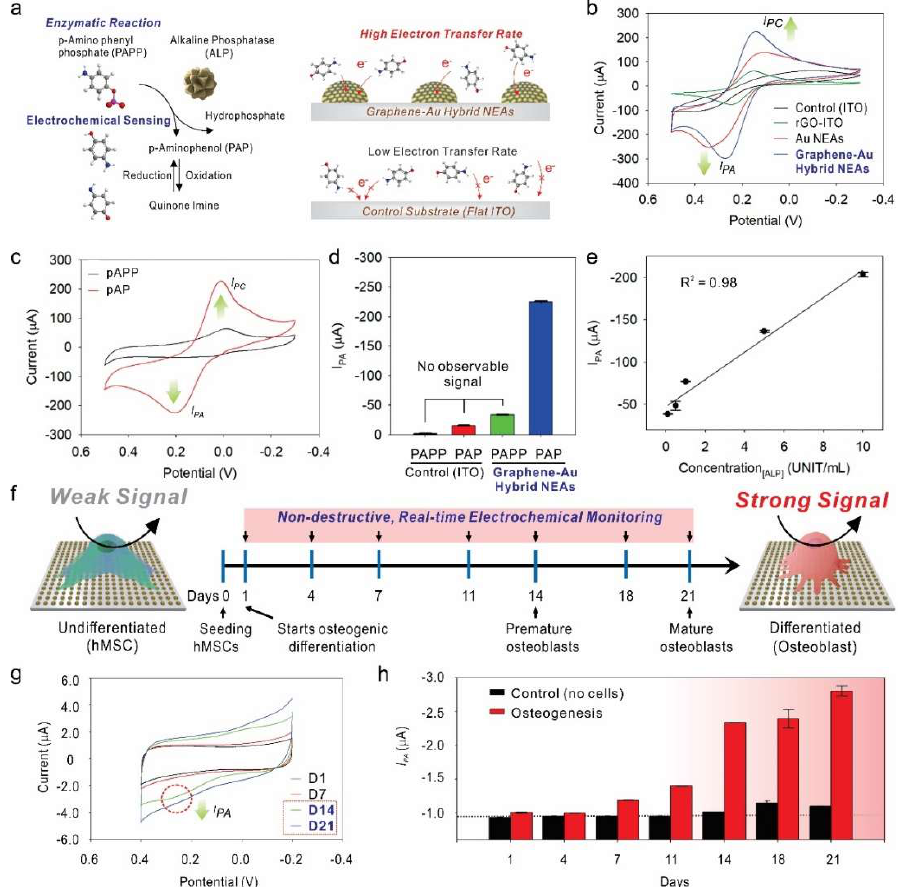
Figure 7. ( a ) Schematic illustration of alkaline phosphatase (ALP) based enzymatic reaction and electrochemical sensing mechanism on the 3D surface in graphene-Au hybrid nanoelectrode arrays (NEAs) compared to 2D flat ITO surface. ( b ) Improved voltammetric response of graphene-Au NEAs compares to bare ITO substrate, rGO-coated ITO substrate, and Au NEAs. ( c , d ) Cyclic voltammogram and Anodic peak (oxidation potential: I PA ) value of P-aminophenyl phosphate (PAPP) on graphene-Au NEAs before and after enzyme reaction with ALP. ( e ) The linear correlations between concentrations of ALP and the current signal at I PA . ( f ) Schematic illustration of electrochemical signal change between undifferentiated hMSCs and differentiated osteocyte based on ALP generation. ( g ) Cyclic voltammetry, and ( h ) calculated I PC values from time-dependent monitoring during osteogenesis of hMSCs (range from D1 to D21). Reproduced with permission from [89], Copyright John Wiley and Sons. Table 4. Comparison of different graphene-based electrode for live cell-based detection.